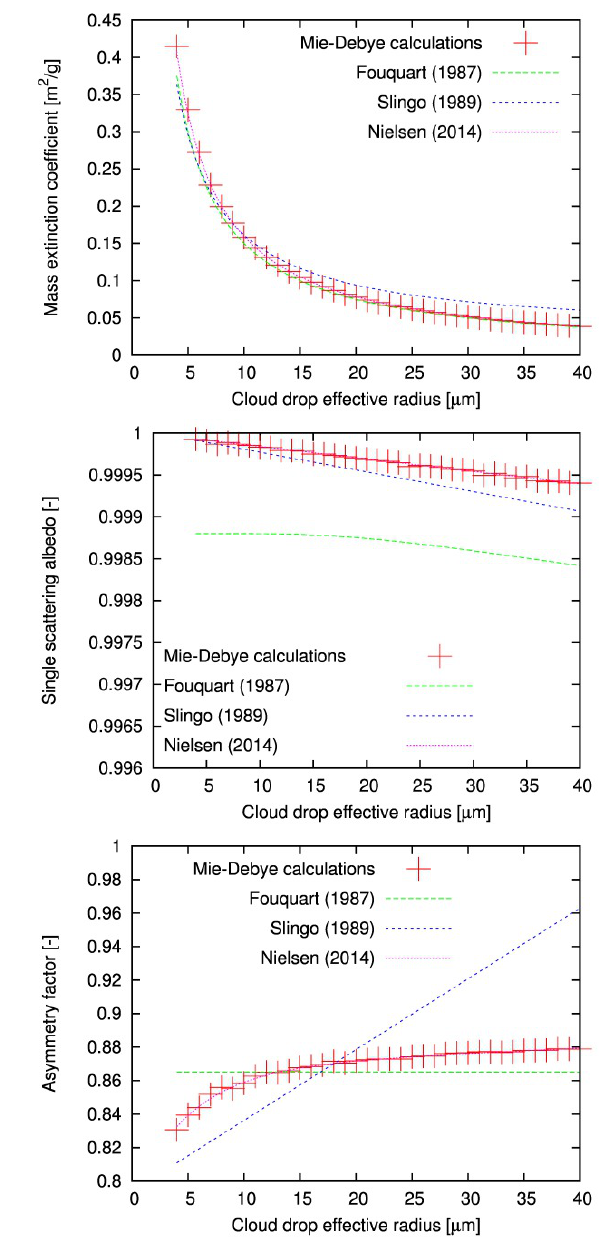
Figure 8. Comparison of mass extinction coefficient parameterisa- tions (upper), single scattering albedo parameterisations (middle) and asymmetry factor parameterisations (lower) for spectral band 4 in the HARMONIE IFS radiation